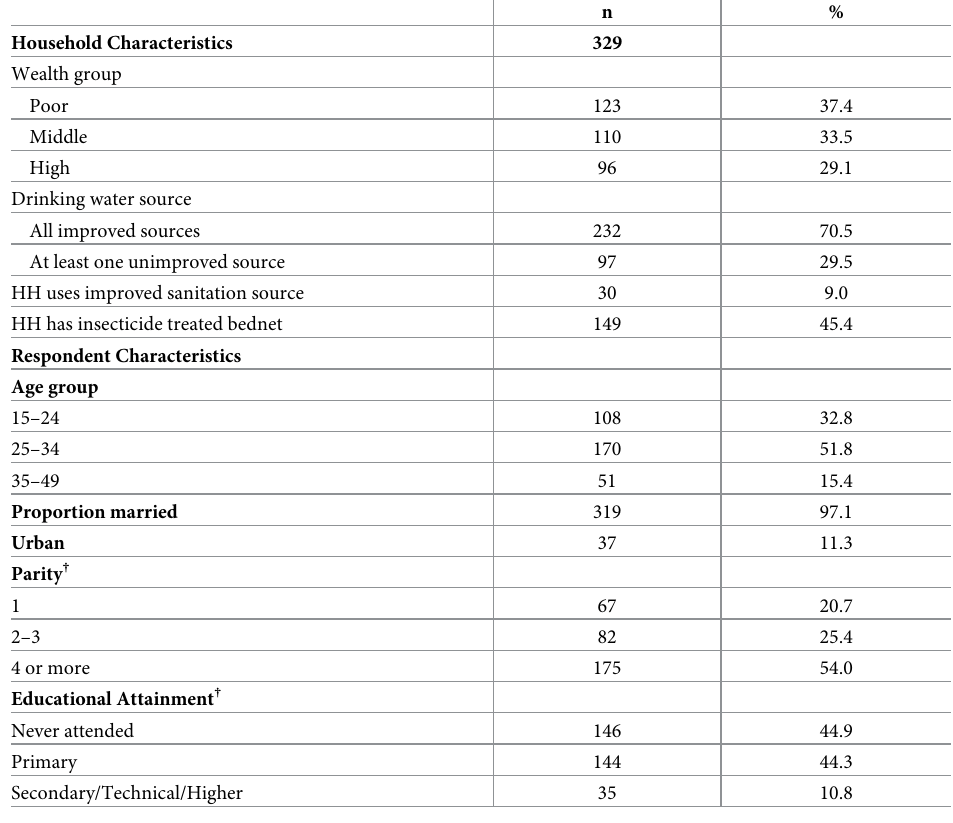
Table 2. Sample characteristics of women enrolled in PMA-MNH study